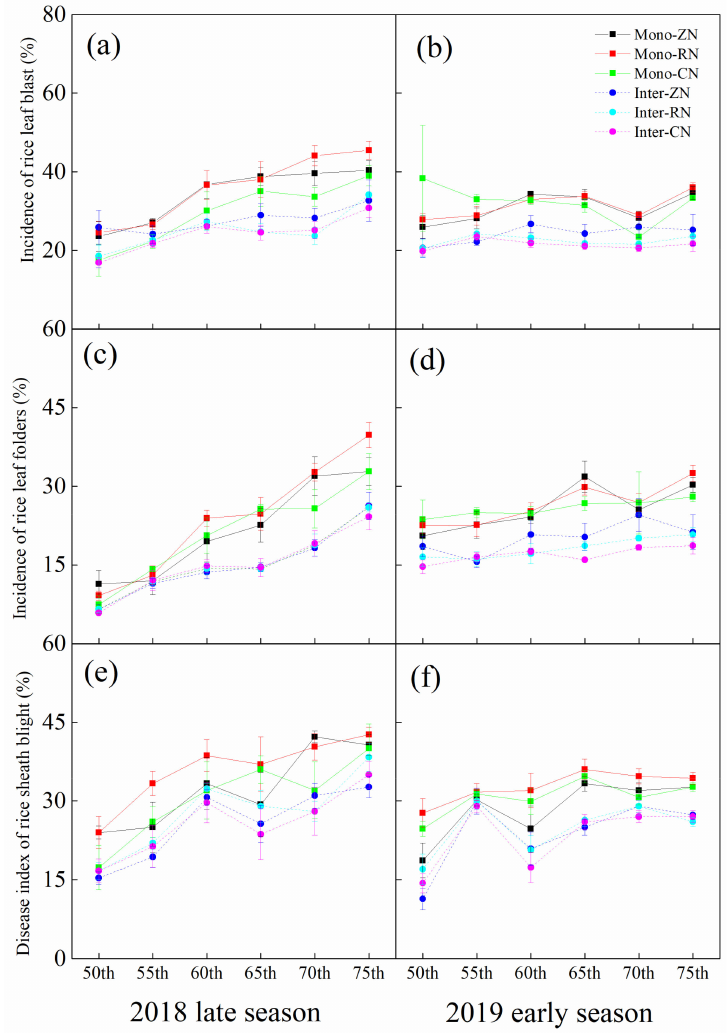
Figure 2. Pest and disease of rice on the 50th, 55th, 60th, 65th, 70th, and 75th days after transplanting. “Mono”, monocropping; “Inter”, Intercropping. ZN, RN, and CN indicate the 0, 140, and 180 kg ha − 1 N fertilizer levels, respectively. ( a , c , e ) and ( b , d , f ) denotes 2018 late season and 2019 early season,